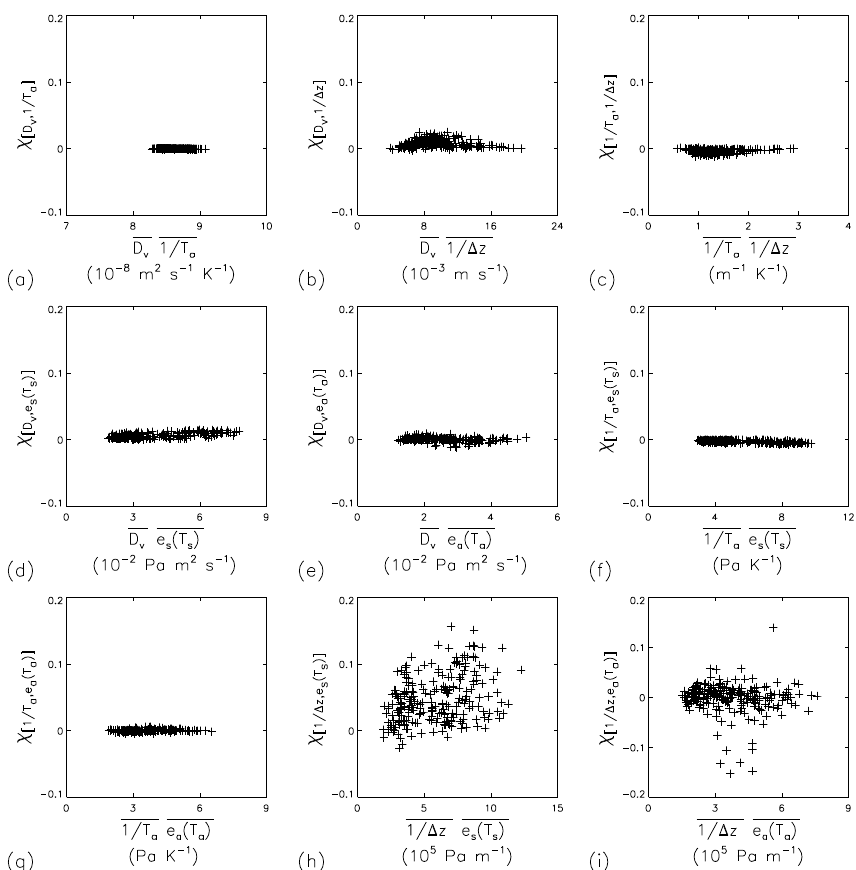
Fig. 1. Relation between the covariance-based correction factors (per Eq. 8) and the relevant product of the means for all nine combination for 237 days as follows: (a) D v , 1